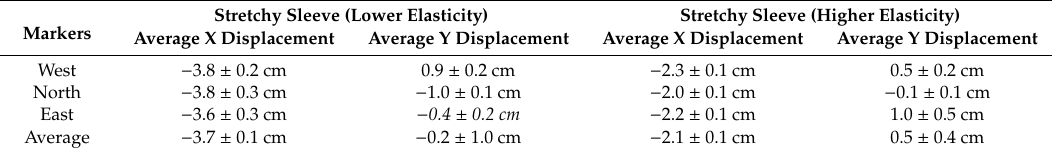
Table 3. Average displacements and standard deviations in the X and Y directions for the three markers on each side, for the more stretchy and less stretchy sleeves, at θ f = 0 ◦ after 10 consecutive flexions. The last row also contains the averages and standard deviations of the data across the West, North, and East sides, for